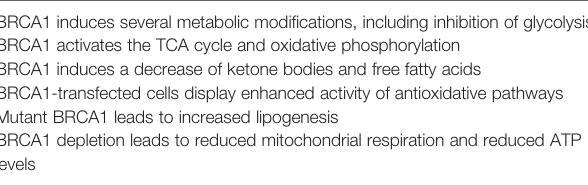
TABLE 2 | Metabolic actions of